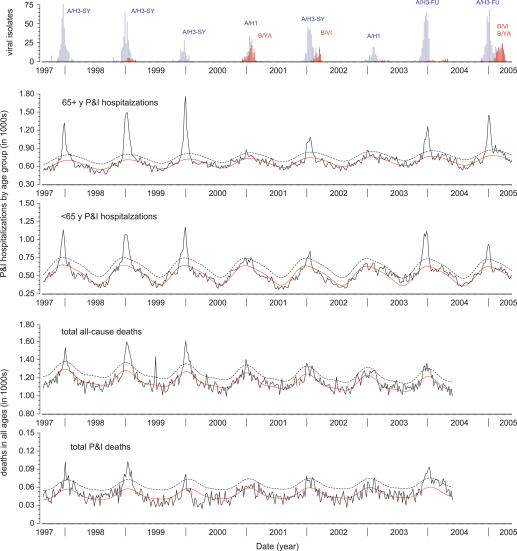
Weekly P&I Hospitalizations and All-Cause and P&I Deaths in New York CityObserved P&I hospitalizations by age group from 1998–1999 to 2004–2005, and deaths for all ages from 1998–1999 to 2003–2004, are shown as black lines. Seasonally expected Serfling baseline levels are shown as red lines, and two-standard-deviation thresholds are shown as dashed lines. Catastrophic event deaths were removed from the data, and heat-wave period deaths were censored from the Serfling analysis. Observed P&I deaths during the 1999–2000 season were low due to a changeover from ICD-9 to ICD-10 coding. Codes in top graph: A/H3-SY, influenza A(H3N2) Sydney; B/VI, influenza B/Victoria; A/H1, either A(H1N1) New Caledonia or A(H1N2) Wisconsin; A/H3-FU, influenza A(H3N2) Fujian; B/YA, influenza B/Yamagata; and A/H3-CA, influenza A(H3N2) California.